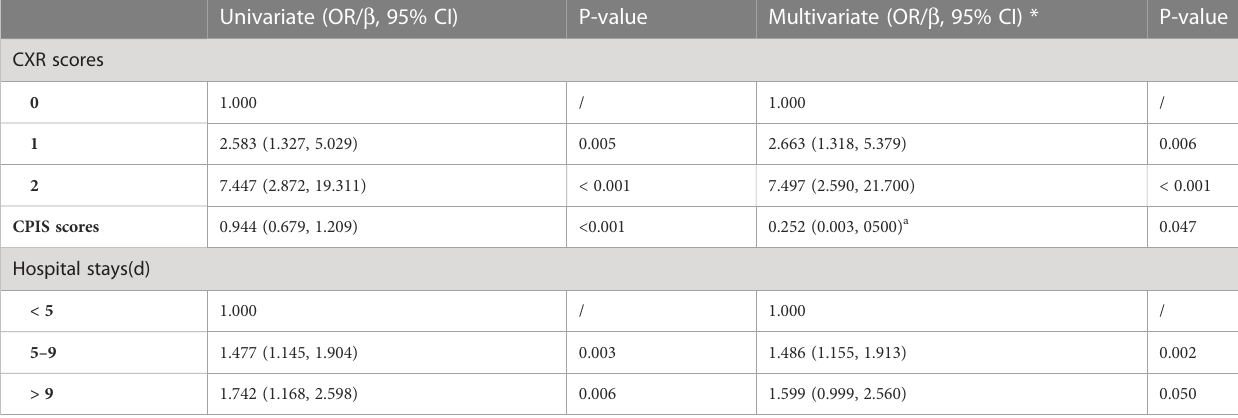
TABLE 4 Association among S100A8/A9 with clinical symptoms and prognosis in children with CAP.